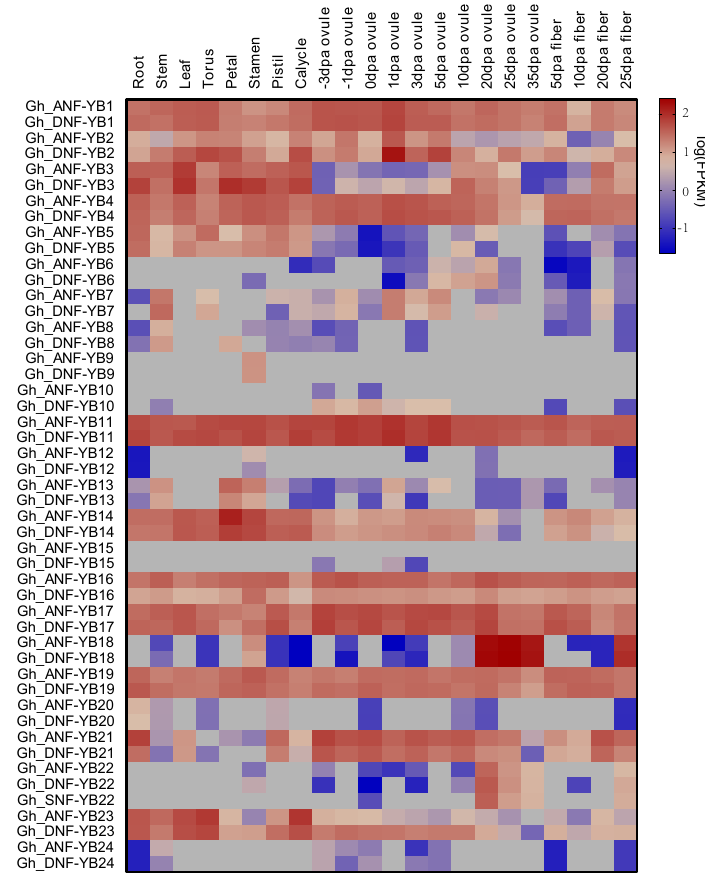
Figure 4. Gene expression patterns of NF-YB genes in a variety of upland cotton tissues. The raw data for RNA-Seq were downloaded from NCBI and analysed using Tophat and Cufflinks [35]. Gene expression levels are depicted with different colour on the scale. Blue and red represent low and high expression,